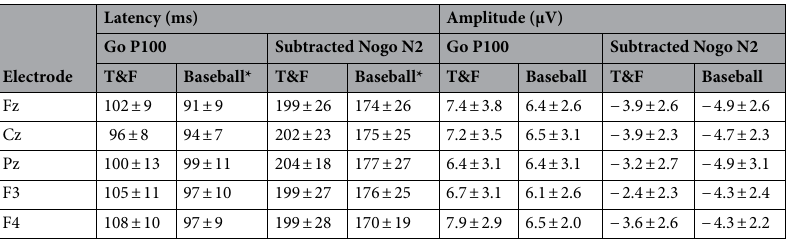
Table 1. The peak latency and amplitude ± S.D of somatosensory Go P100 and subtracted Nogo N2. The asterisk shows a significant groups difference. * p < 0.05.